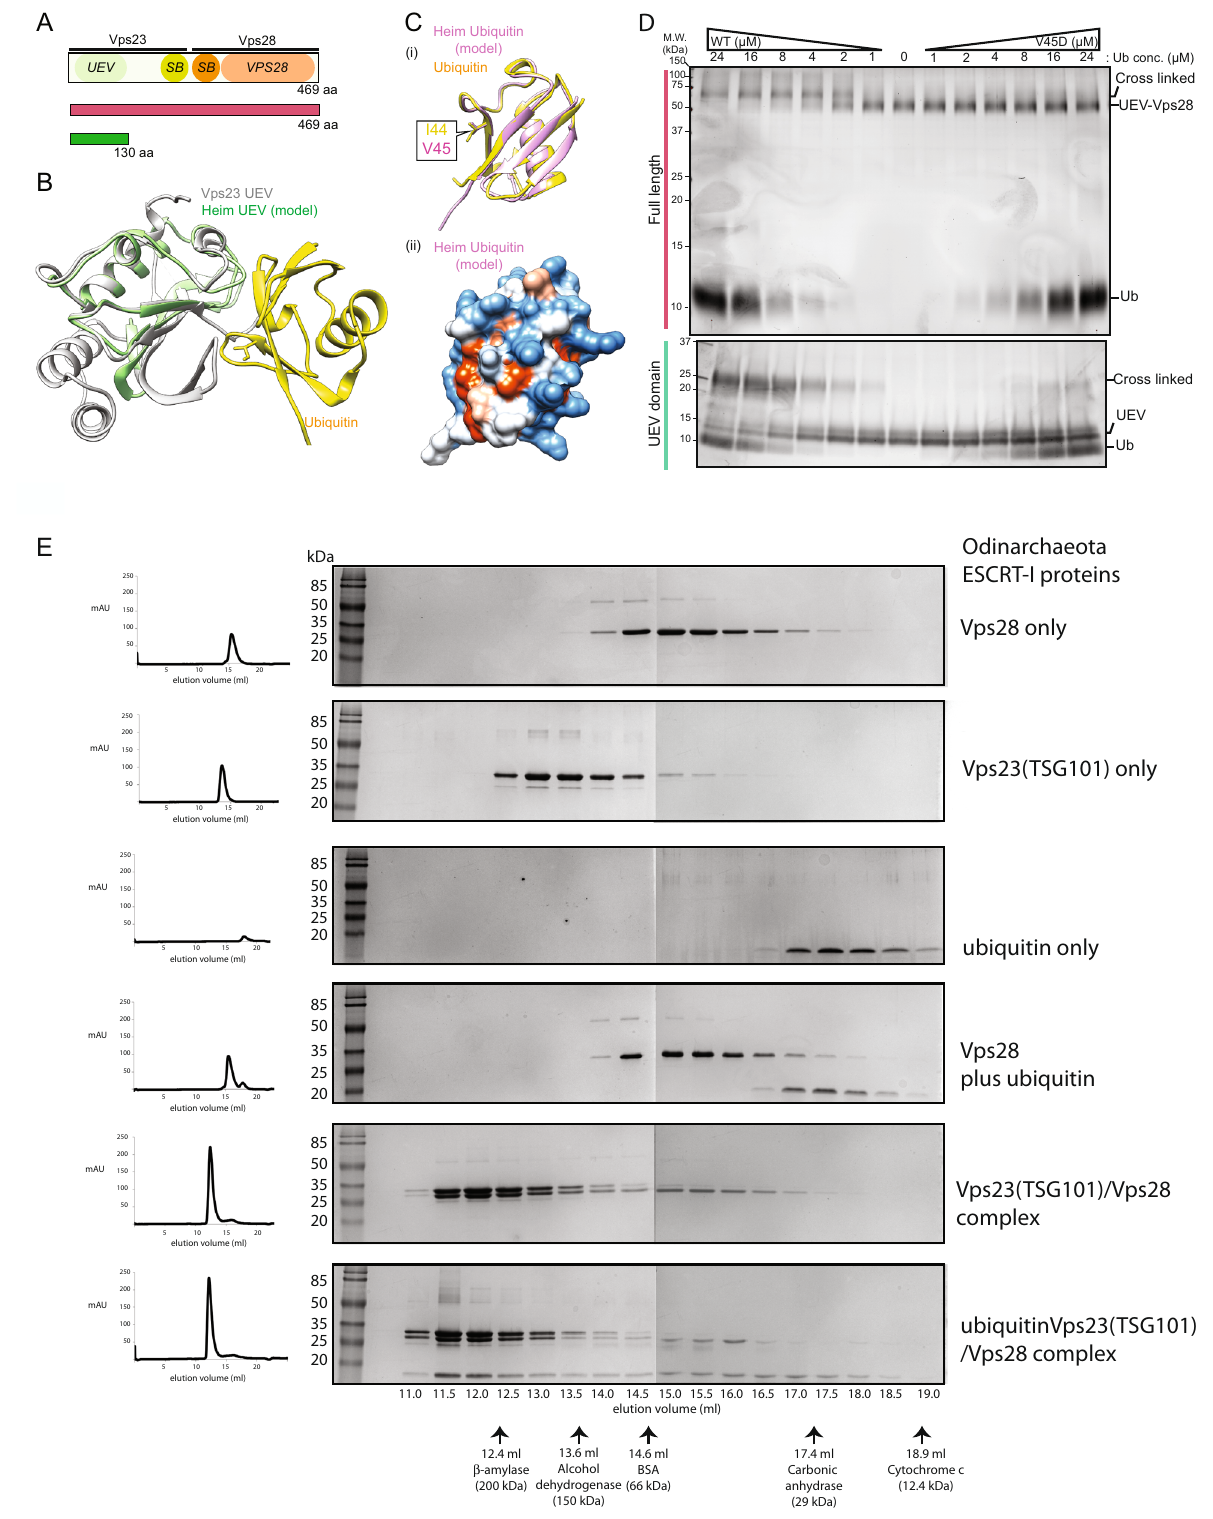
(Fig. S8) arose from a heterotrimeric archaeal ESCRT-I subcomplex composed of a Vps23 homodimer and Vps28. Structure of the Asgard ESCRT-II subcomplex . Turning to the ESCRT-II subcomplexes, our genomic analysis identi fi ed close homologues of Vps22 and Vps25 in Asgard archaeal genome